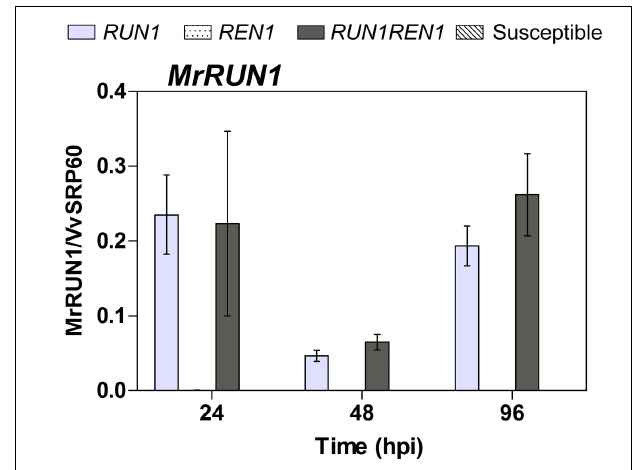
FIGURE 7 | RT-qPCR analysis of MrRUN1 expression in response to E. necator . Samples were collected at 24, 48, and 96 hpi. Expression data were related to Vv60SRP housekeeping gene. Data points represent means ± SEM considering three biological